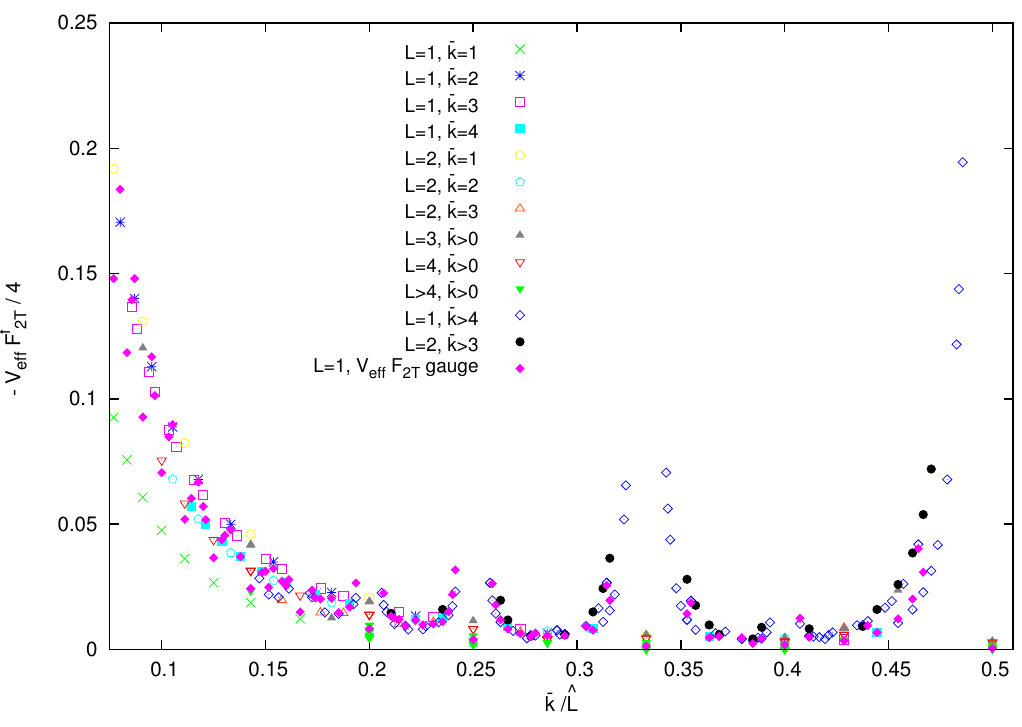
Figure 9. The function (cid:0) V e(cid:11) F f ( L ) = 4 for the plaquette in a S 1 plane is plotted as a function of 2 T (cid:22) k= ^ L for massless r = 1 Wilson fermions. For comparison we also display the pure gauge results for the TEK, L = 1